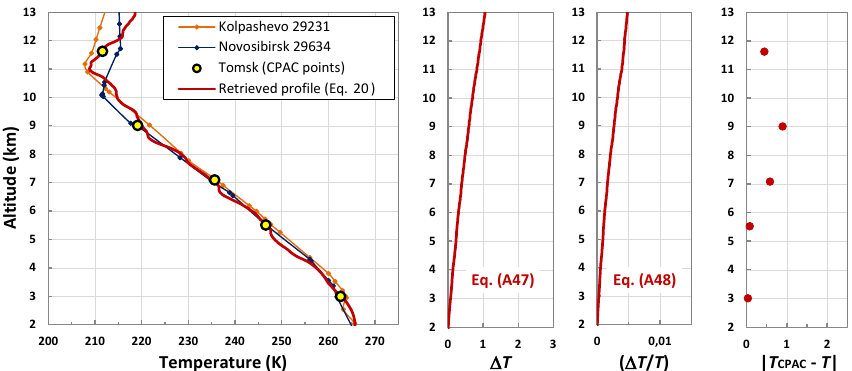
Figure 9. (1 April 2015) Temperature profile retrieved using the temperature retrieval function (Eq. 20) derived from the calibration function suggested by Gerasimov and Zuev (2016). The uncertainties (cid:49) T and ( (cid:49) T / T ) are calculated by Eqs. (A47) and (A48), respectively.